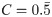
Example of non-optimal behaviour of the Greedy algorithm.(a) Original network with clustering coefficient C = 0. (b) Network with two links selected using the Greedy algorithm and clustering coefficient C=0.5¯. (c) Optimal solution with clustering coefficient C=0.605¯. The value corresponding to the dashed lines show the increase of clustering coefficient by adding the corresponding link to the network in (a). After adding one of the links depicted as dashed lines to the network in (c), the contribution of the other link increases to 0.35¯, as the two nodes incident to that link now have one common neighbour more (see Eq 1).